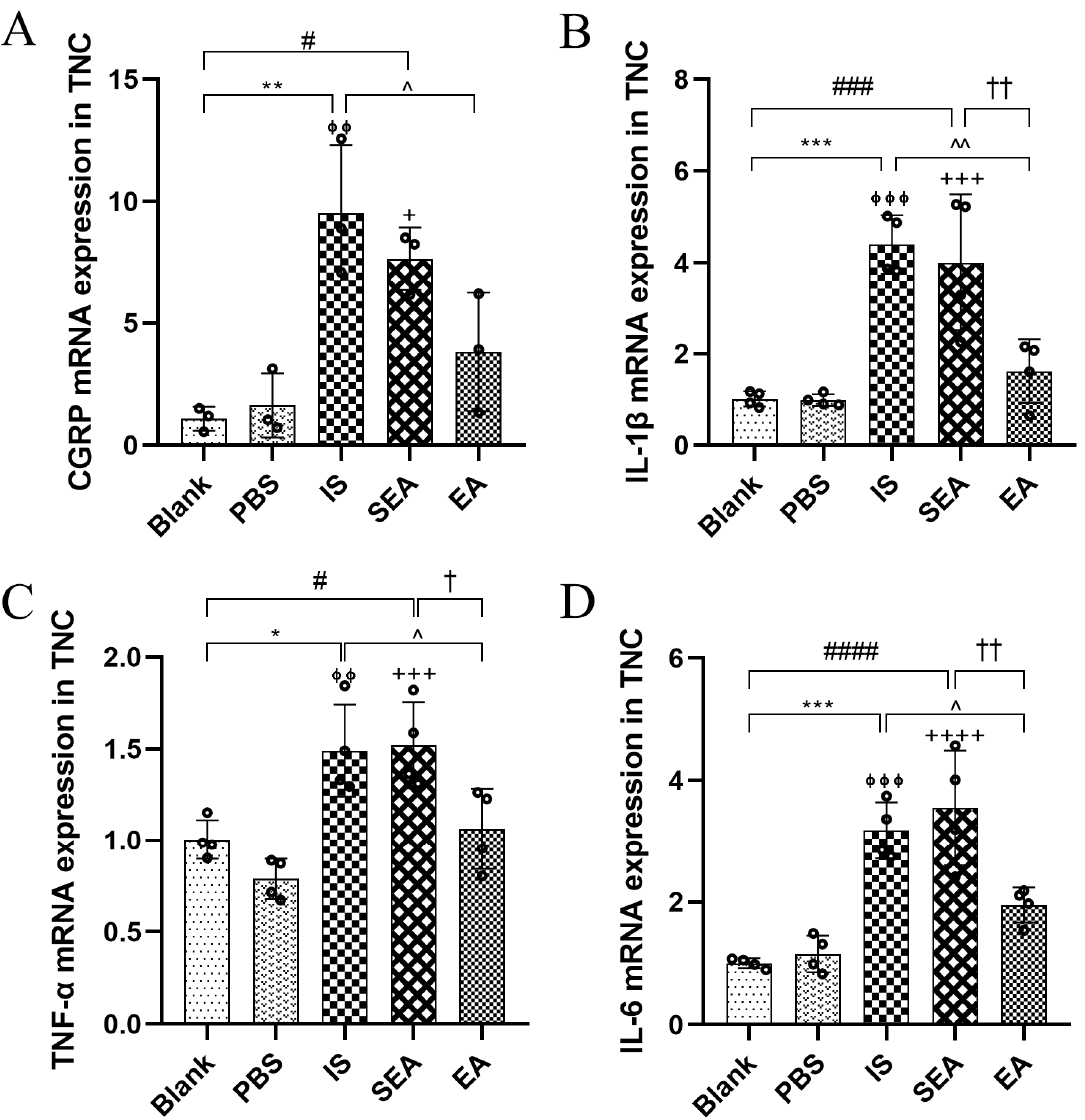
Figure 3. mRNA expressions of CGRP ( A ) and inflammatory cytokines, including IL ‐ 1 β ( B ) TNF ‐α ( C ), and IL ‐ 6 ( D ), in TNC in the five groups of rats as detected by RT ‐ PCR ( n = 3–4/group). Repeated IS infusions into dura increased the mRNA expressions of CGRP and the above inflammatory cytokines, while EA decreased mRNA levels of CGRP and the above inflammatory cytokines. ANOVA and Tukey’s post hoc analysis test were performed and data are presented as the mean ± standard deviation. * p < 0.05, ** p < 0.01, *** p < 0.001, Blank vs. IS; ⏀⏀ p < 0.01, ⏀⏀⏀ p < 0.001, PBS vs. IS;